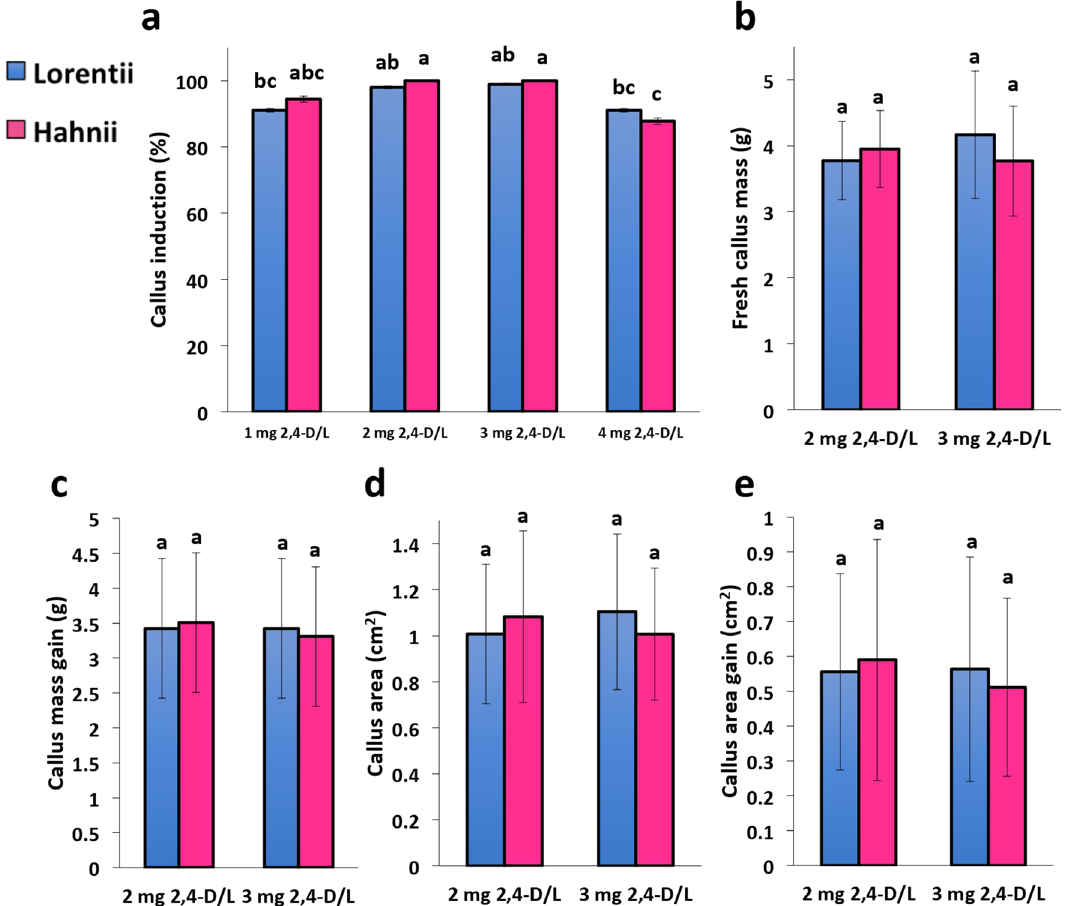
Figure 5. Effects of 2,4-D auxin on callus production for cvs Lorentii and Hahnii of Sansevieria trifasciata . ( a ) Callus induction, ( b ) fresh callus mass, ( c ) fresh mass gain index, ( d ) callus area, and ( e ) callus increase index were evaluated after 42 days of growth with different doses of 2,4-D. Values are means ± SD. Means with different letters are significantly different according to Tukey’s test ( p ≤